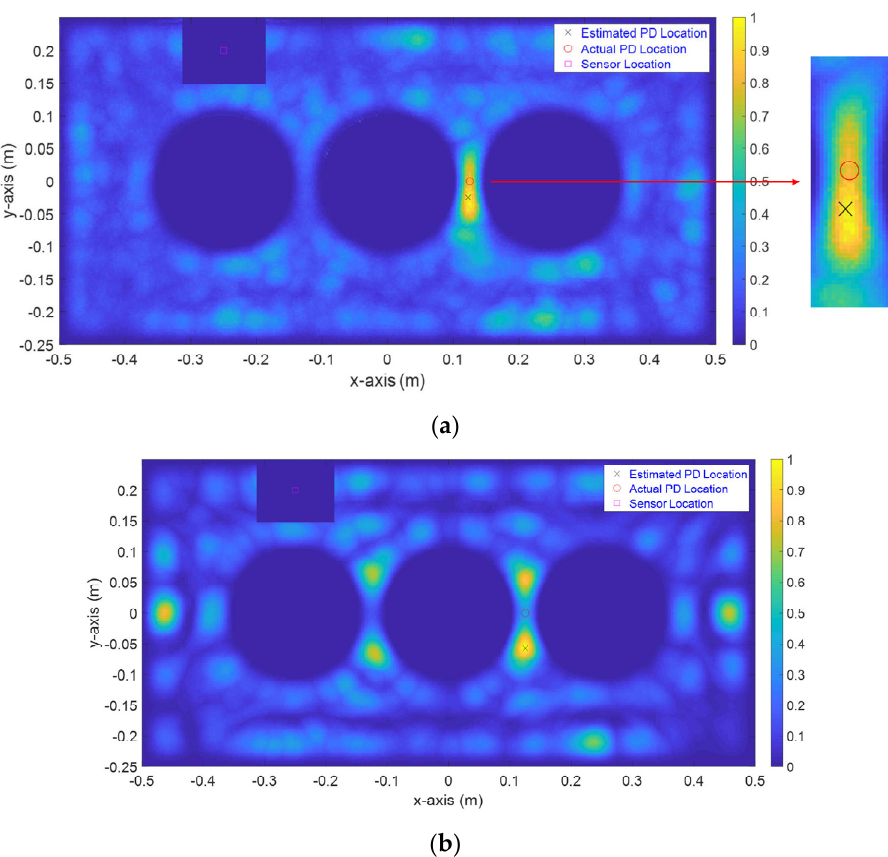
Figure 9. The distribution of normalized maximum electric field power over the complete simula- tion time interval on the computational domain, ( a ) obtained by the EMIF method with a 25.1 mm localization error, ( b ) obtained by the EMTR method with a 57.5 mm localization error. In this case study, the EMTR method cannot localize the source between two adjacent metallic objects.